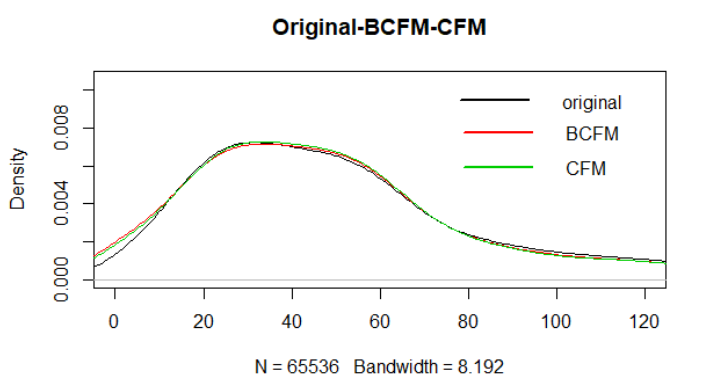
Figure 13. A slice density graph of the original, CFM, and BCFM images.